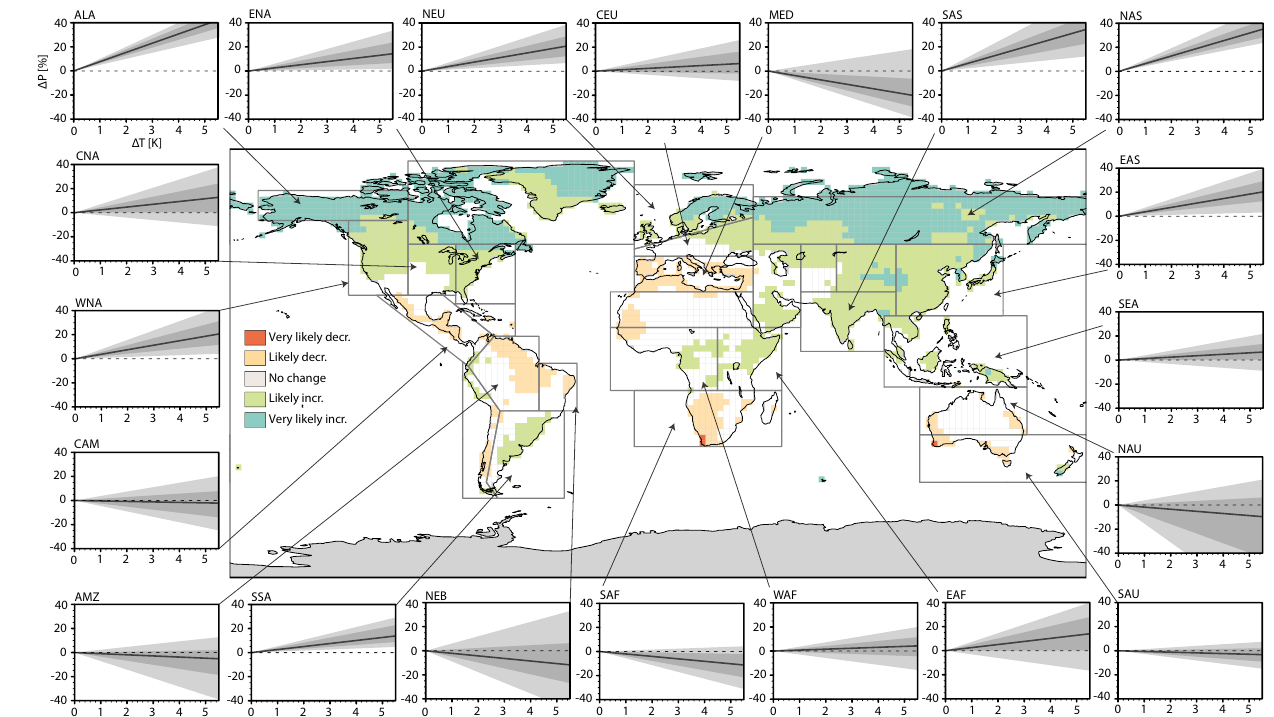
Figure 3. Conceptual summary of the probability that the slope of P is negatively/positively different from zero considering all climate models and all scenarios. Panel plots illustrates the uncertainty distribution of the sensitivity of P to global temperature change as a function of global mean temperature change averaged for each SREX (Special Report on Managing the Risks of Extreme Events and Disasters to Advance Climate Change Adaptation) region outlined in the map (the shading in each panel plot corresponds to those illustrated in Fig.